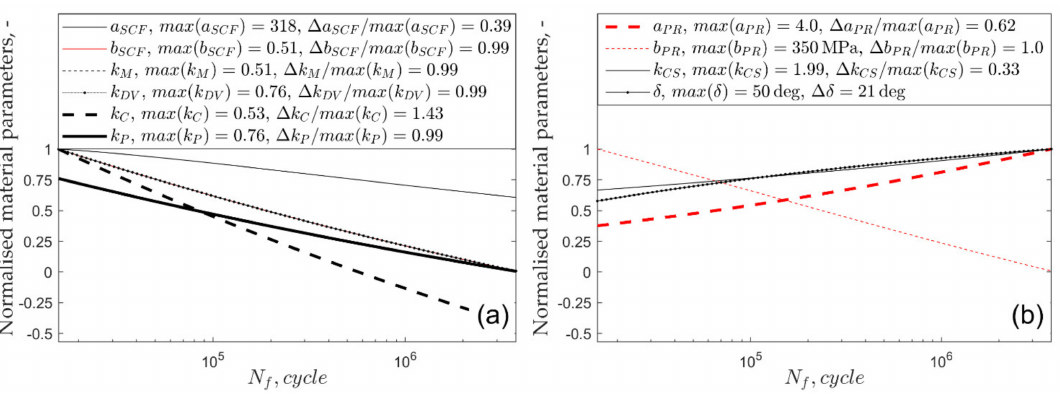
Figure 4. Normalised material parameters in the function of number of cycles to failure for S355 steel: ( a ) linear models and ( b ) non-linear models.